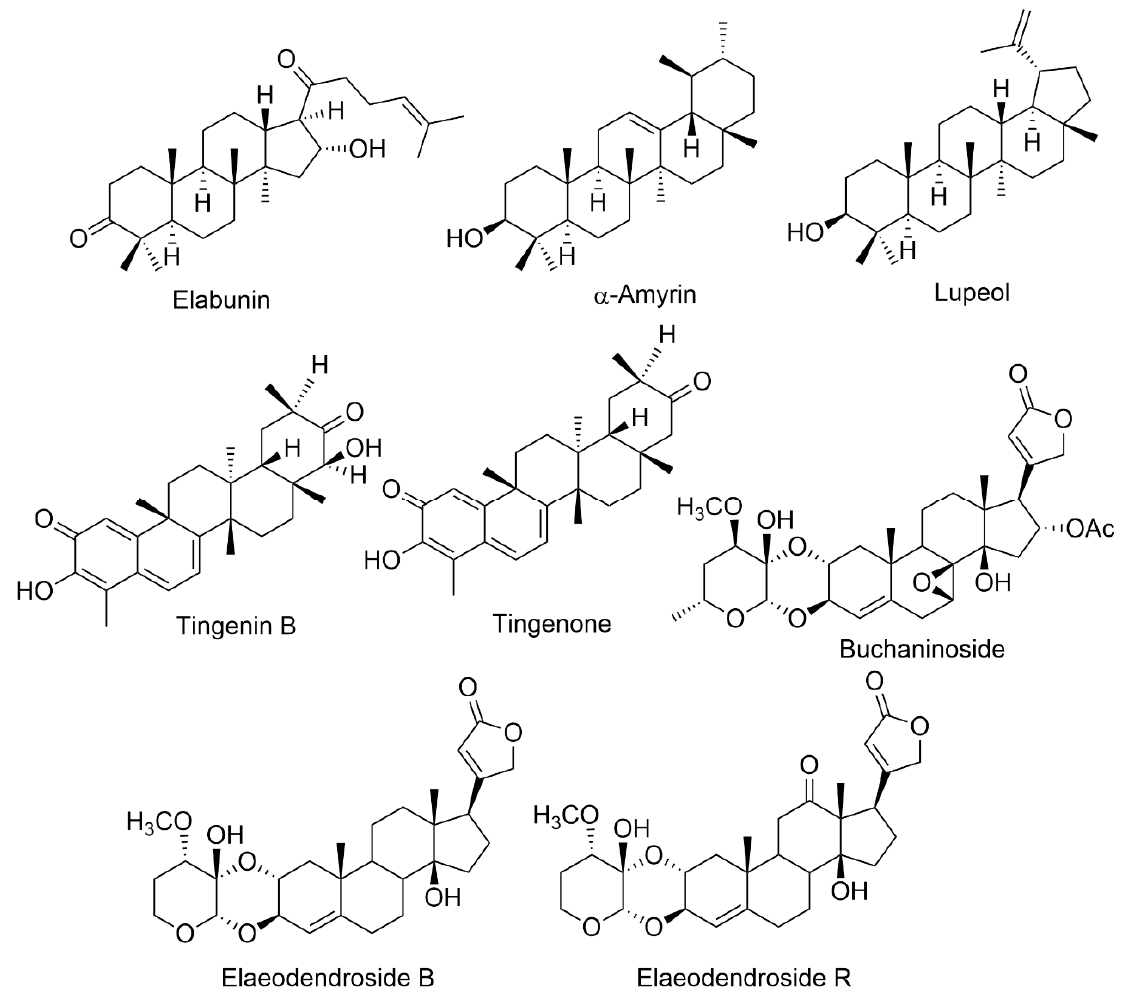
Figure 1. Chemical structures of some selected bioactive compounds isolated from Elaeodendron spe ‐ cies.